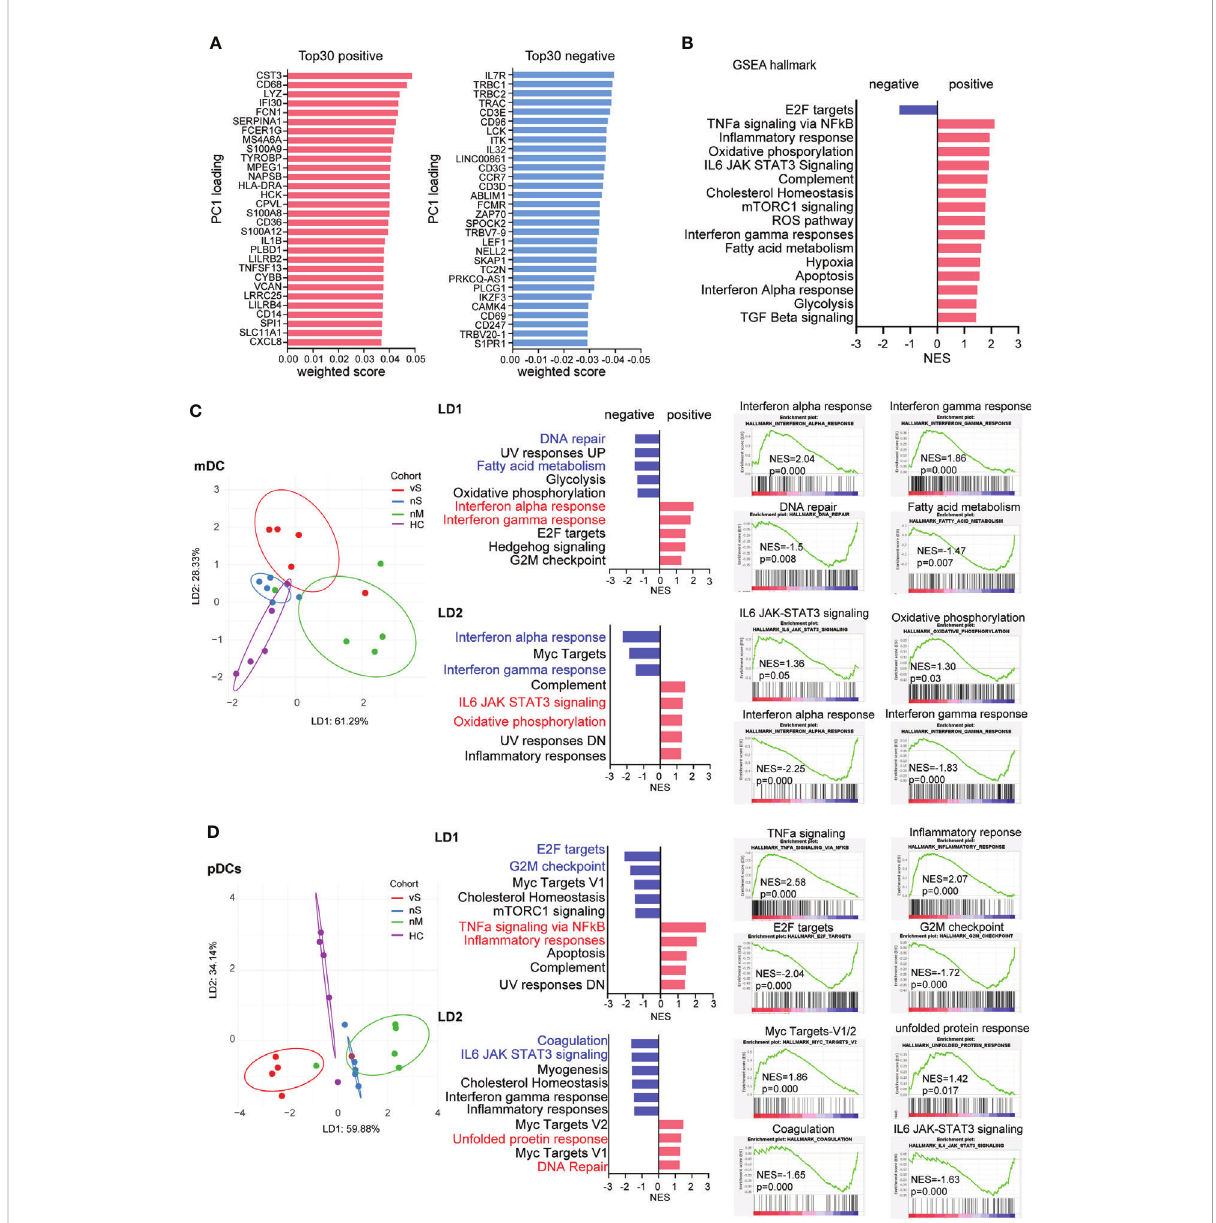
FIGURE 3 mDCs and pDCs can distinguish COVID-19 patients with different disease severity (A) . Top 30 weighted scores for positive (red) and negative (blue) PC1 loading. (B) gene set enrichment analysis (GSEA) by using hallmark gene sets, normalized enrichment scores are plotted (FDR p<0.05), and Red bars show the enrichment signatures for a positive weighted score, and bars re fl ect negative score. (C) Linear discriminant analysis on mDCs was used to separate HD (purple), nM (green), nS (blue), and vS (red) groups. Hallmark gene sets were used for GSEA, and the fi ve signatures with strongest enrichment (red) or de-enrichment (blue) are shown. Enrichment plots for the top 2 signatures are shown individually. (D) Linear discriminant analysis on pDCs was used to separate HD (purple), nM (green), nS (blue), and vS (red) groups. Hallmark gene sets were used for GSEA, and the fi ve signatures with strongest enrichment (red) or de-enrichment (blue) are shown. Enrichment plots for the top 2 signatures are shown